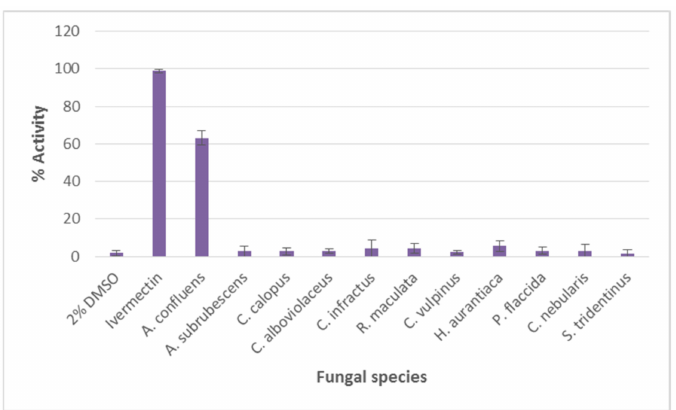
Figure 1. In vitro anthelmintic activity of crude extracts (500 µ g/mL) of fungal fruiting bodies against C. elegans